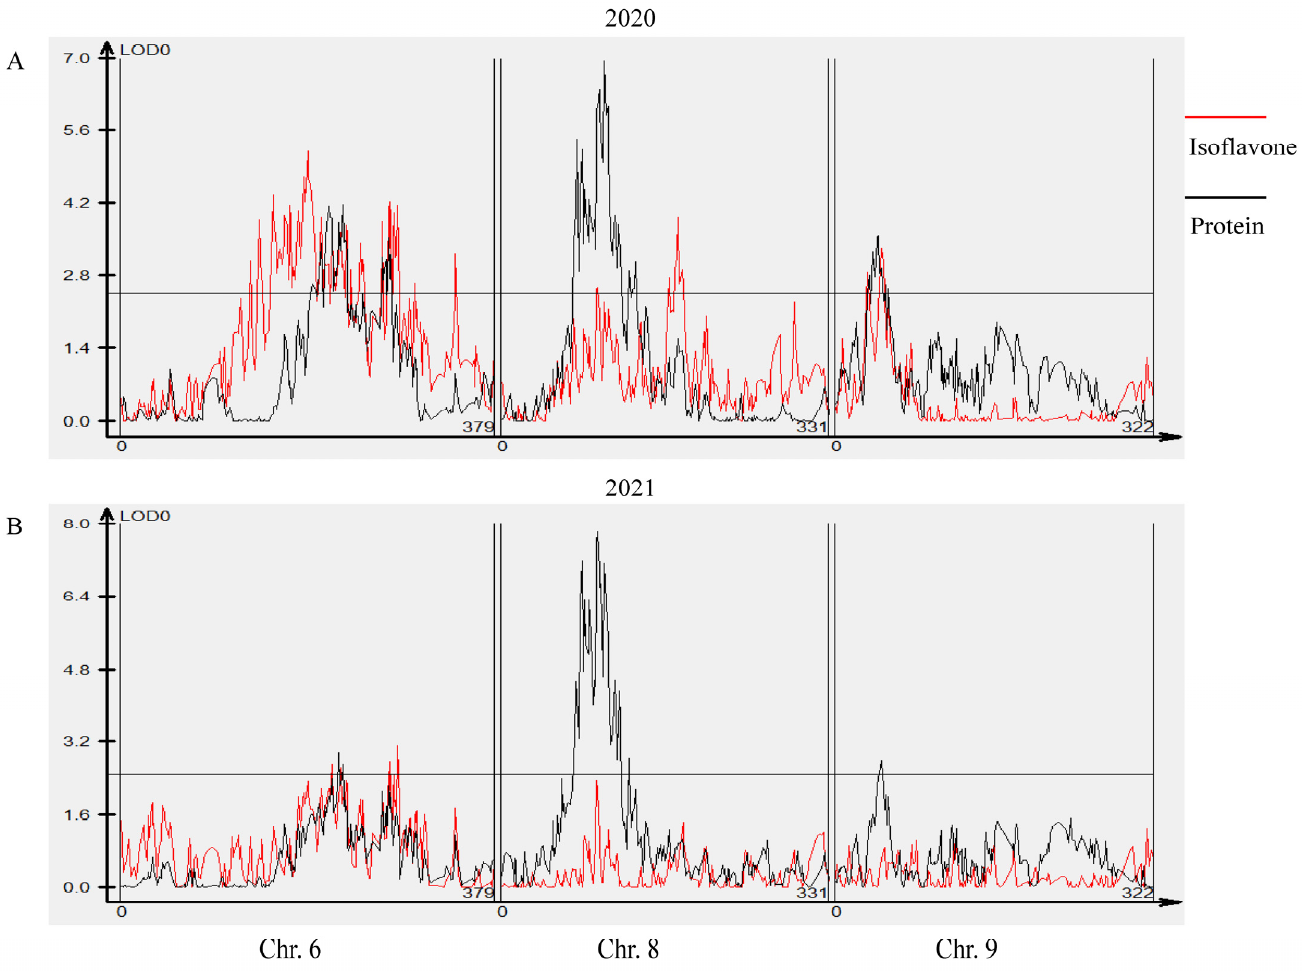
Figure 5. Joint QTL mapping analysis for seed protein and isoflavone content on chromosomes 6, 8 and 9 performed using Cartographer software. Different chromosomes are separated by double solid lines; the horizontal line represents the threshold LOD value of 2.5; the red and black curve lines represent LOD values of total isoflavone traits and protein traits, respectively. ( A ) LOD value distribution in 2020. ( B ) LOD value distribution in 2021.